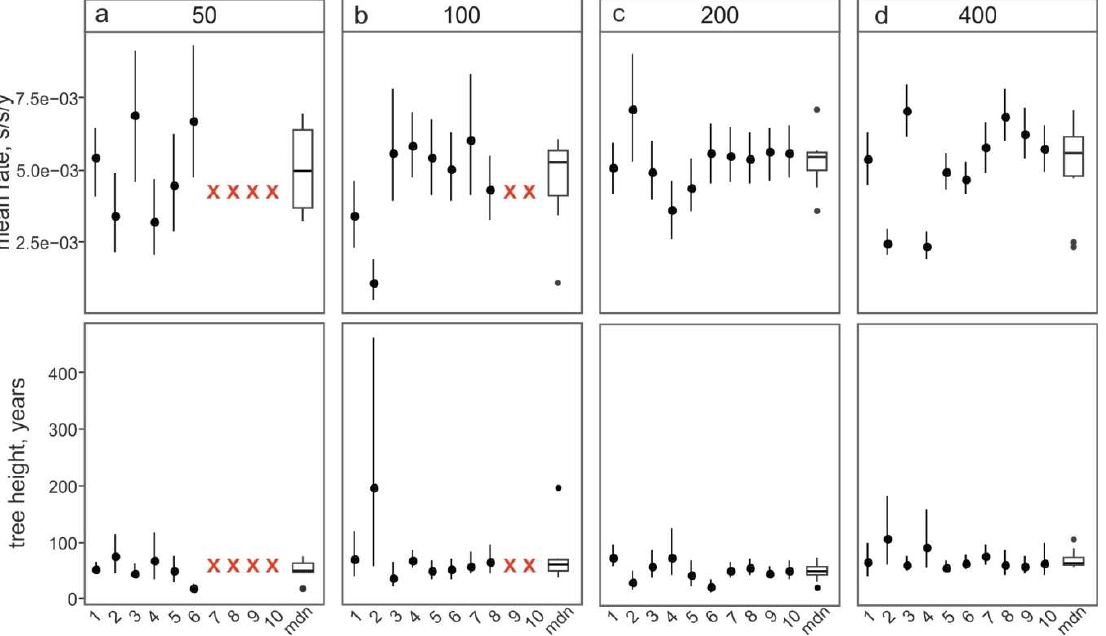
Figure 3. The effect of the number of sequences in the alignment on the substitution rate and root height inferred using Bayesian phylogenetic analysis. The median values and 95% high probability density (HPD) intervals of the mean substitution rate and tree heights are shown as dots and ticks for each of ten sampling replications with the specified number of sequences, respectively. Red crosses indicate runs that failed to converge after 200 million generations. Boxplots show the median values (mdn) and outliers for each panel ( a – d.